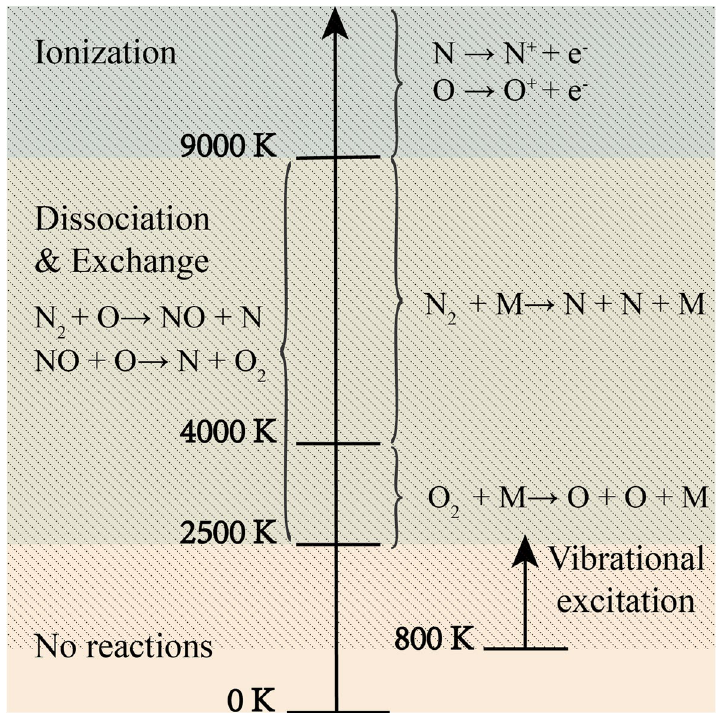
Fig. 1 Temperature ranges of vibrational excitation and chemical reactions of